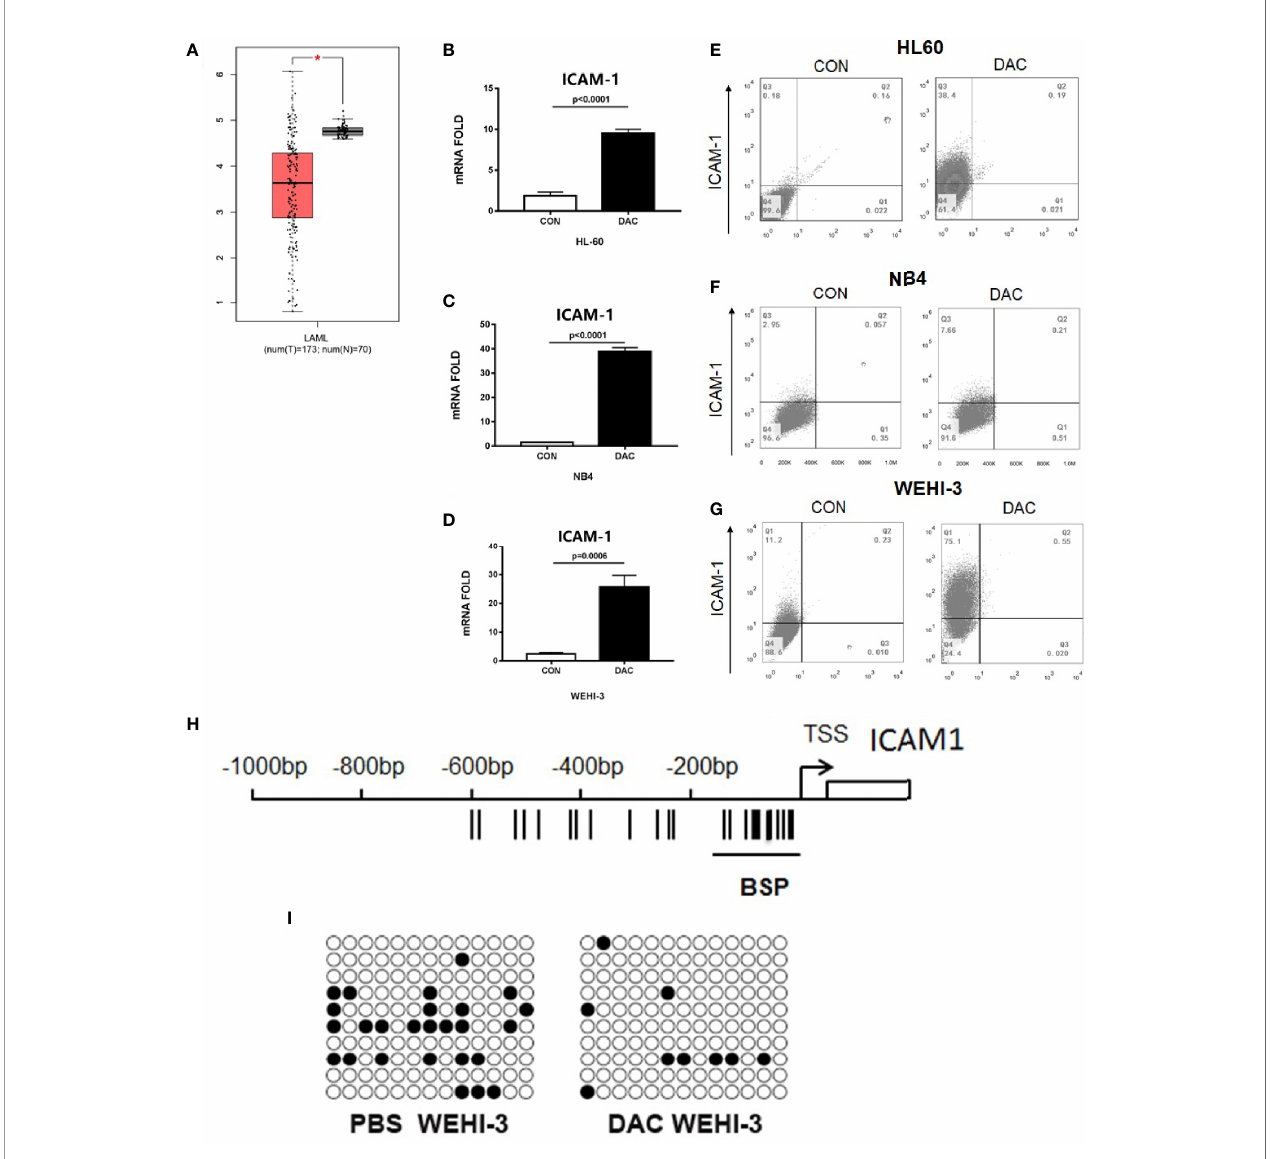
FIGURE 1 | ICAM-1 silenced in AML patients and reversed by hypomethylating. (A) The ICAM-1 mRNA Chip analysis of 70 healthy controls (N) and 173 AML patients (T) (TCGA). Q-PCR anlysis of ICAM-1 mRNA expression in (B) HL-6, (C) NB4, and (D) WEHI-3 cells treated with or without decitabine (mean ± SD, n=4). FACS analysis of ICAM-1 expression in (E) HL60, (F) NB4, and (G) WEHI-3 (n=3, typical data). (H) Bisul fi te sequencing PCR of mouse ICAM-1 methylation sequencing fragment. (I) Methylation rate of WEHI-3 treated and untreated with DAC reached 20% [left] and 6.92% [right],